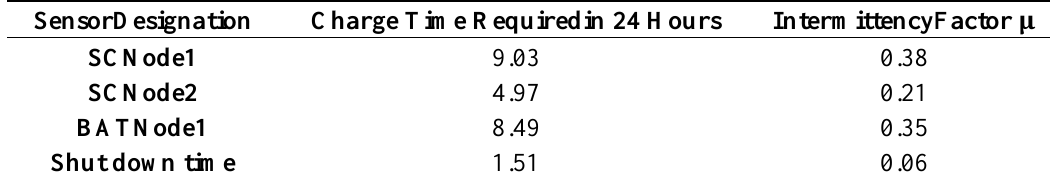
Table 2. Break down of charge time required over 24